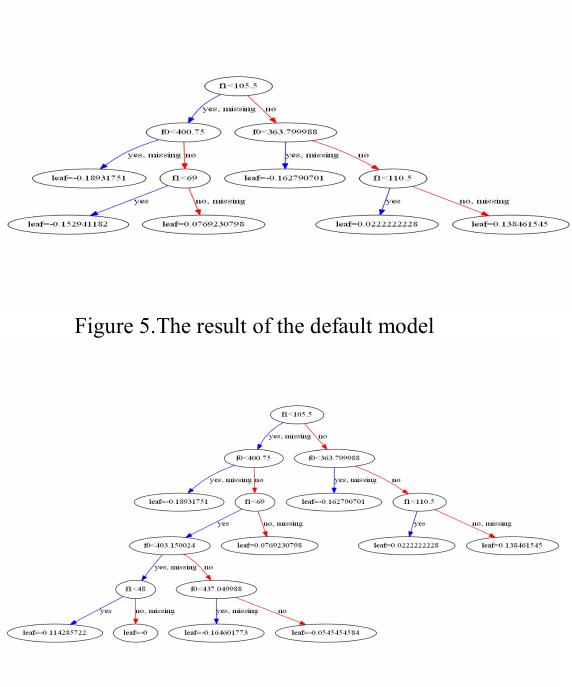
Figure 3. Training set of data on a 9:1 scale